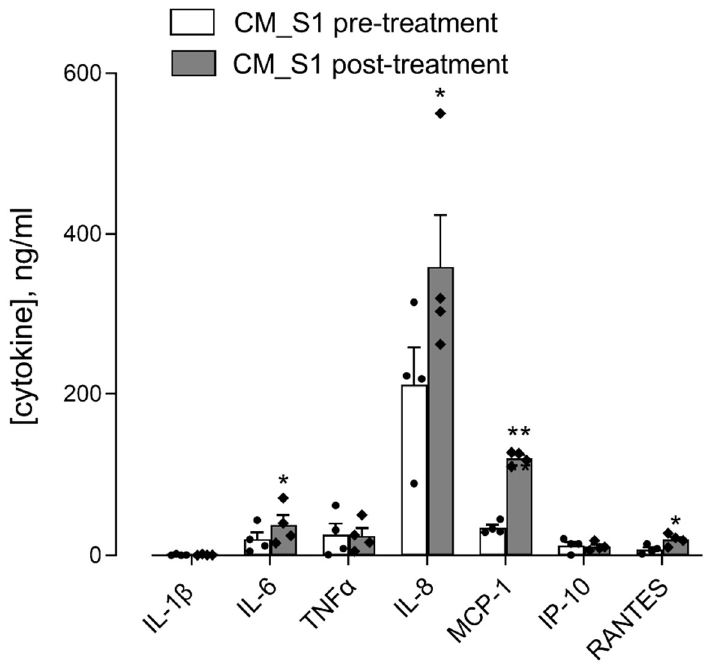
Figure 1. A549 were incubated for 24 h with conditioned medium from monocyte-derived macrophages (MDM) maintained for 16 h in the presence of 10 nM S1 (CM_S1). The amount of the indicated cytokines and chemokines in CM_S1 was measured with an ELISA assay before (pre-treatment) and after (post-treatment) treatment of A549 cells, as described in Methods. Data are means ± SEM of four independent experiment, each performed in quadruplicate. * p < 0.05, ** p < 0.01 vs. CM_S1 pre-treatment.